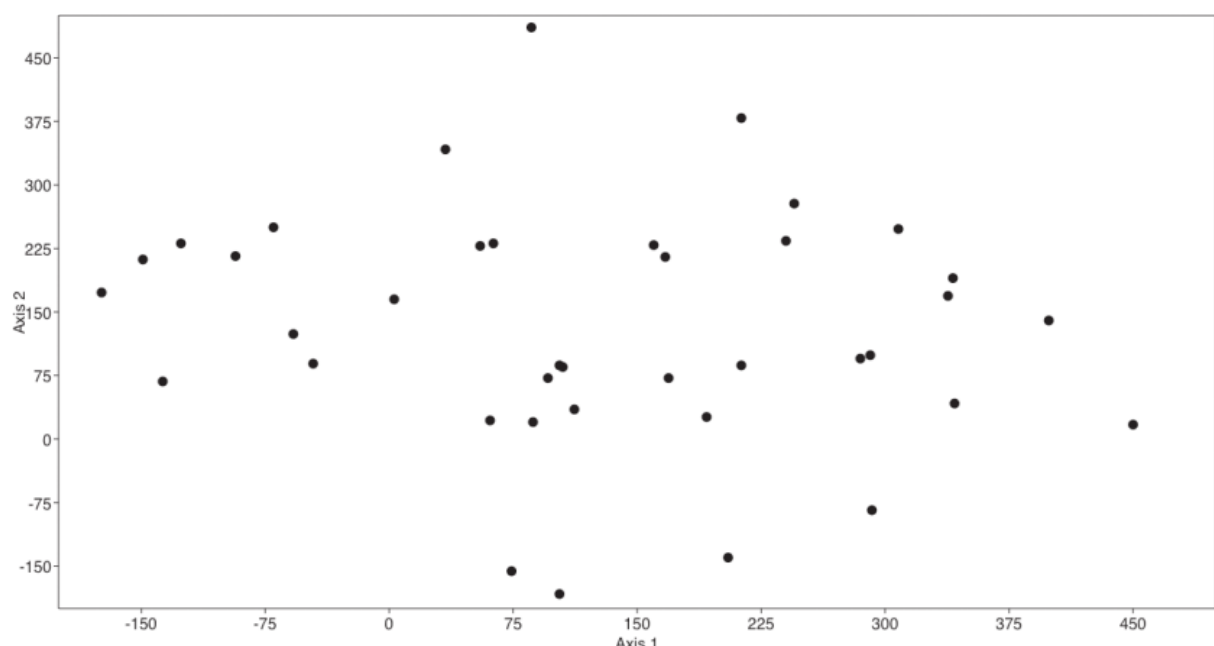
Figure 2. DCA plot of SSR and EST-SSR bands/loci in date palm cultivars showing well-scattered distribution of loci